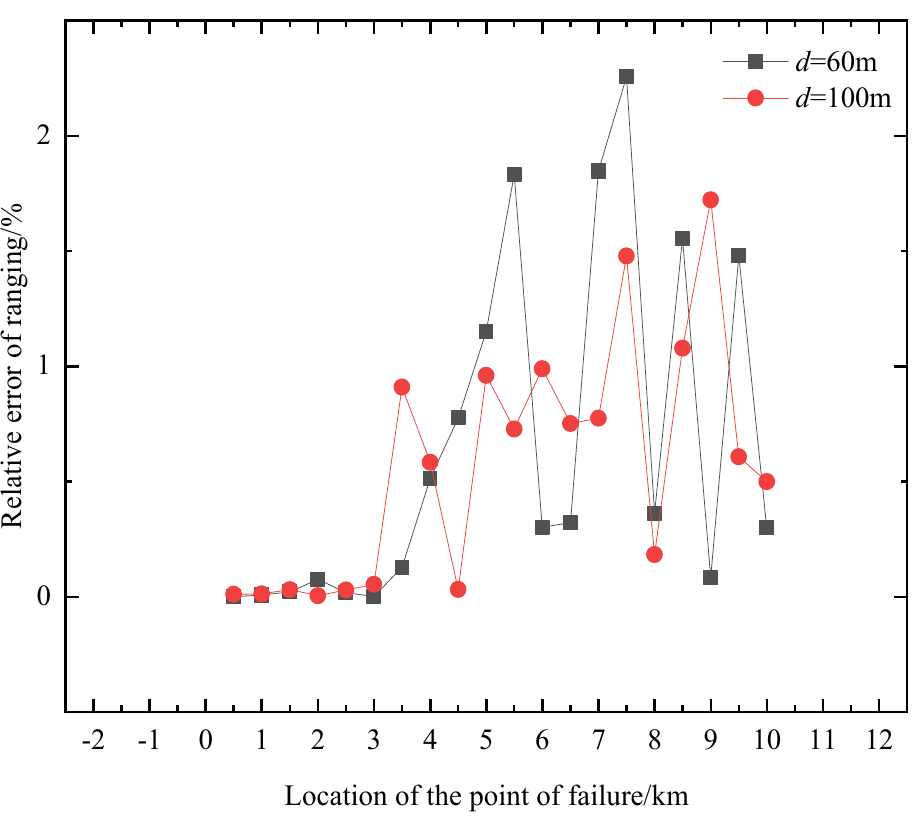
Figure 7. Relative error distribution of ranging at 20 different fault points in different intervals. It can be seen from Figure 7 that the relative fluctuation of the interval of d = 100 m is small, and the relative error of ranging can be controlled within 1.722% when d = 100 m.